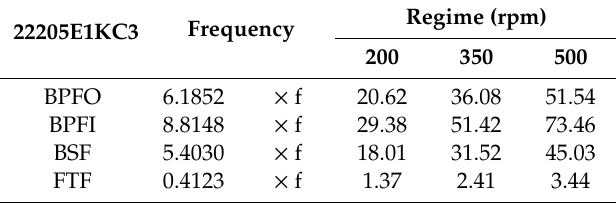
Figure 9. Compression load cell: ( a ) electrical diagram and ( b ) positioning in the test bench.